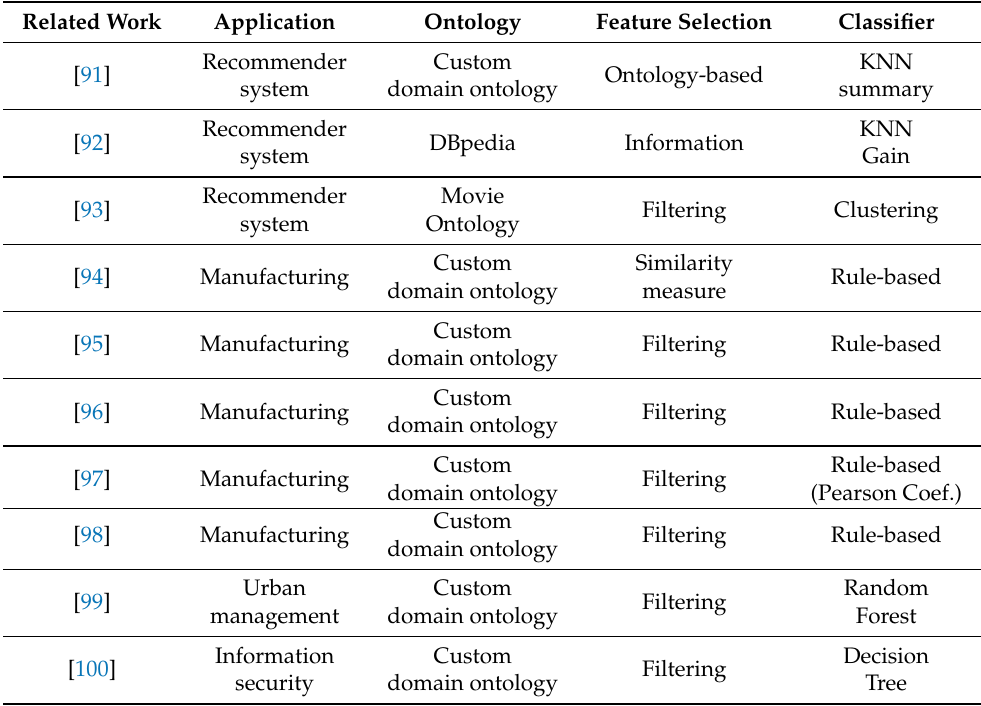
Table 3. Related works organized according to specific